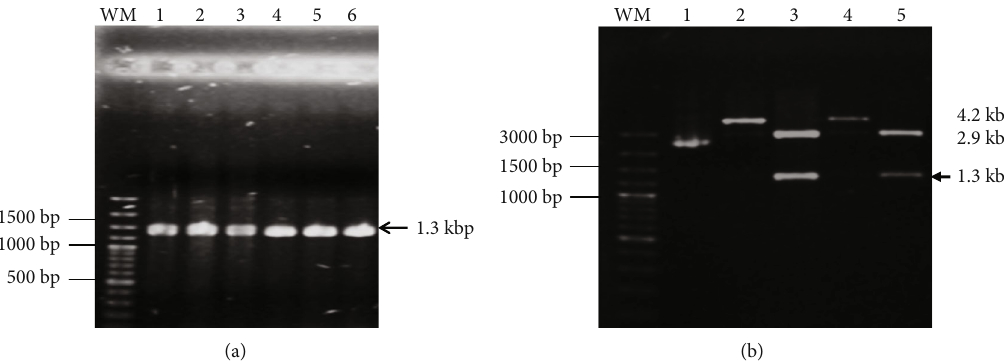
Figure 1: DNA fragment encoding Hi eno , ampli fi cation, and subcloning. (a) Agarose gel stained with ethidium bromide revealing the 1.3 kbp-sized PCR ampli fi cation products (arrow): HibATCC33930 (lane 1), NTHiBUAPPAU (lane 2), HibBUAPNAN (lane 3), ampli fi ed obtained using TOPO::HibBUAPNAN eno plasmid as a template (lane 4), NTHiBUAP96 (lane 5), and ampli fi ed obtained using TOPO::NTHiBUAP96 eno plasmid as a template (lane 6). (b) Design and construction of pRSET-A::HiENO plasmid. Lane 1: